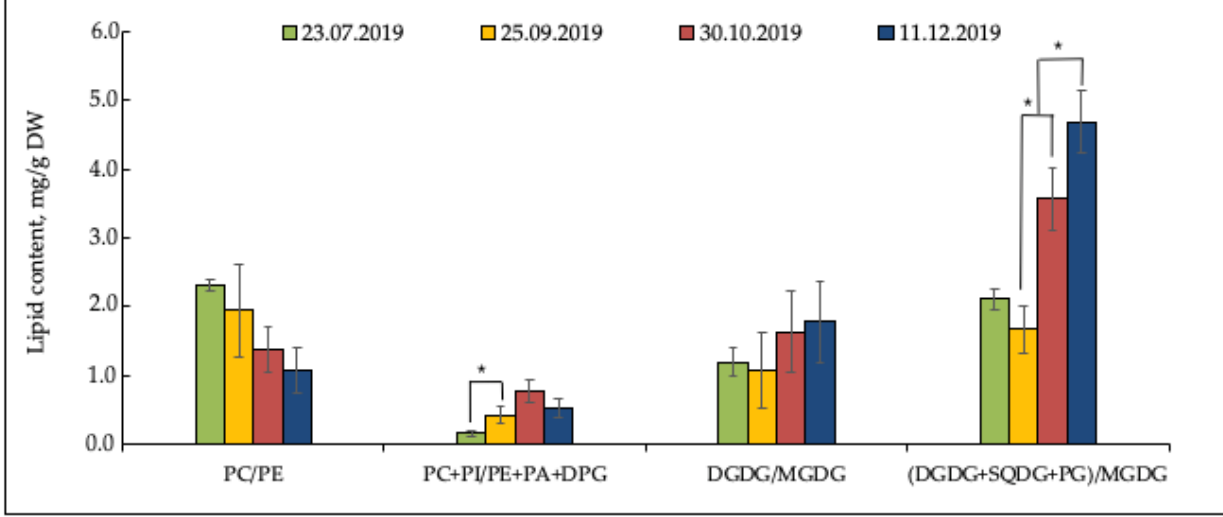
Figure 2. Dynamics of PC/PE, PC + PI/PA + PA + DPG, DGDG/MGDG, (DGDG + SQDG + PG)/MGDG ratios in Ephedra monosperma shoots (mg/g DW) . PC — phosphatidylcholine; PE — phos- phatidylethanolamine; PI — phosphatidylinositol; PA — phosphatidic acid; DPG — diphosphatidyl- glycerol; PG — phosphatidylglycerol; DGDG — digalactosyldiglycerid, MGDG — monogalactosyldi- glycerid, SQDG — sulfoquinovosyldiacylglycerol. Data is shown as the mean ± SD ( n = 3); * signifi- cant differences according to Student’s t -test. Table 1. Timing of developmental stages for E. monosperma plants and meteorological parameters during the research period (Central Yakutia).